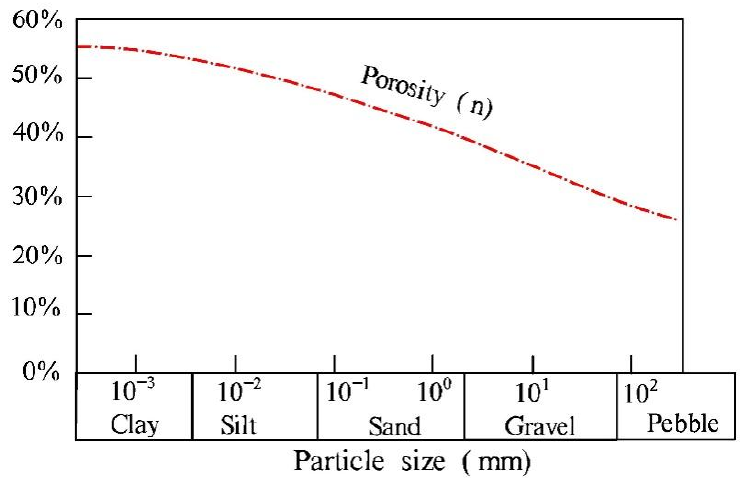
Figure 13. Variation curves of porosity in different aqueous media.